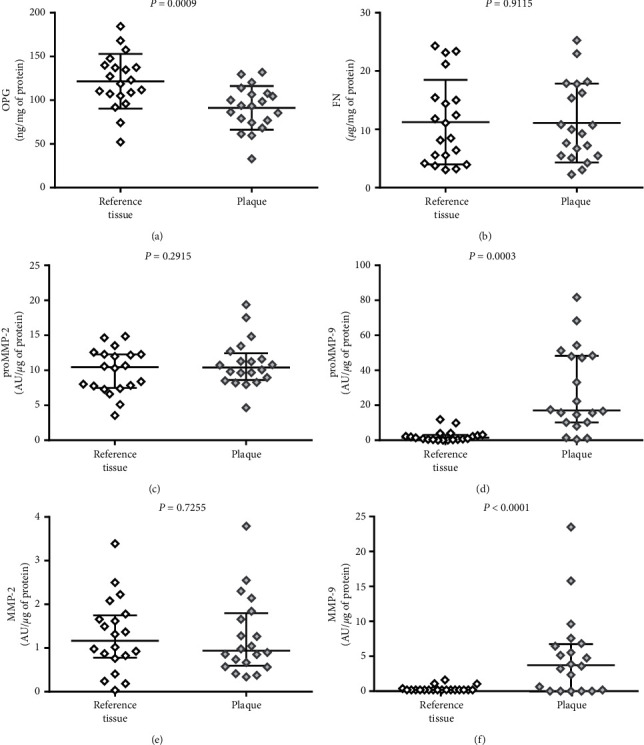
Comparison of (a) osteoprotegerin (OPG), (b) fibronectin (FN), (c) matrix metalloproteinase 2 proenzyme (proMMP-2), (d) matrix metalloproteinase 9 proenzyme (proMMP-9), (e) matrix metalloproteinase 2 active form (MMP-2), and (f) matrix metalloproteinase 9 active form (MMP-9) in atherosclerotic plaque and reference tissue, from the same patients. The middle lines represent the median, and the whiskers extend from the 25th to the 75th percentiles.